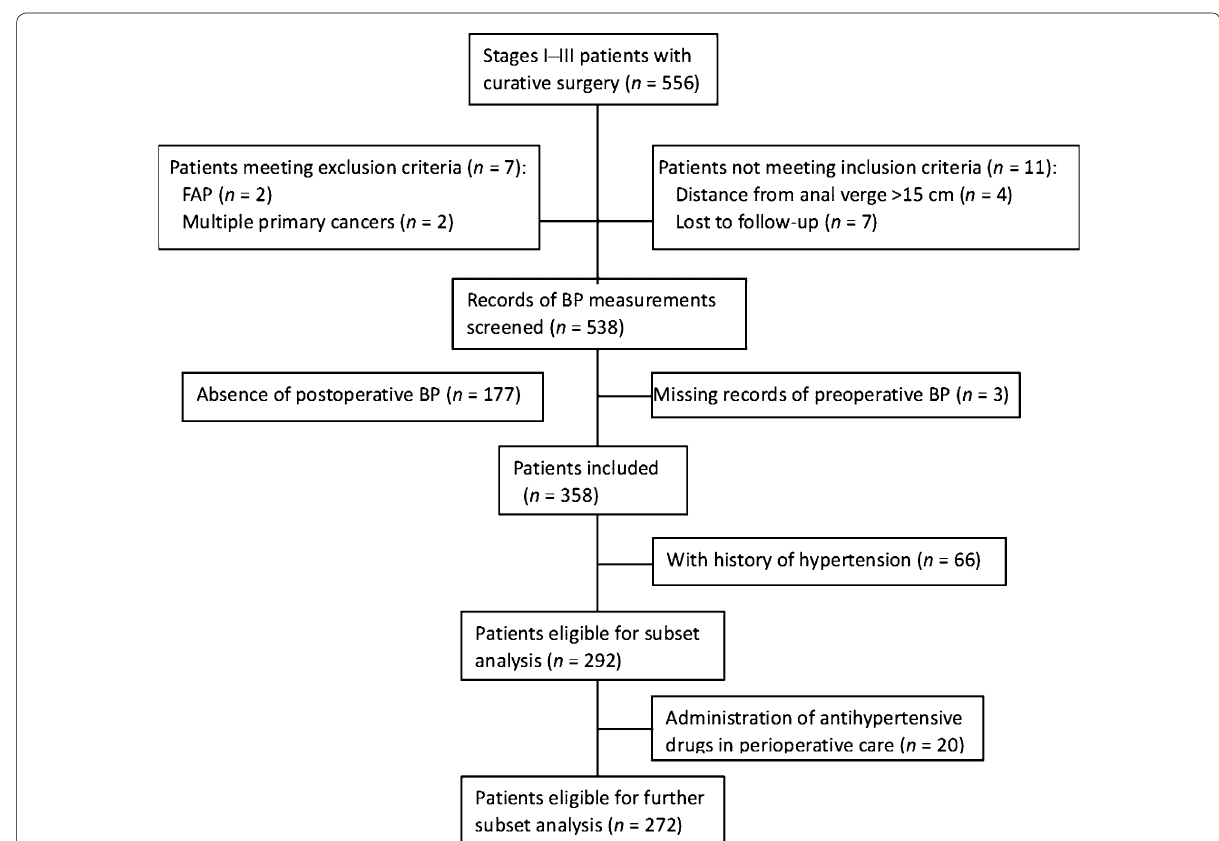
Fig. 1 Flow diagram of patient selection. This diagram presents case disposition in the analysis of the association between perioperative BP and long‑term survival in patients with rectal cancer. BP blood pressure, FAP familial adenomatous